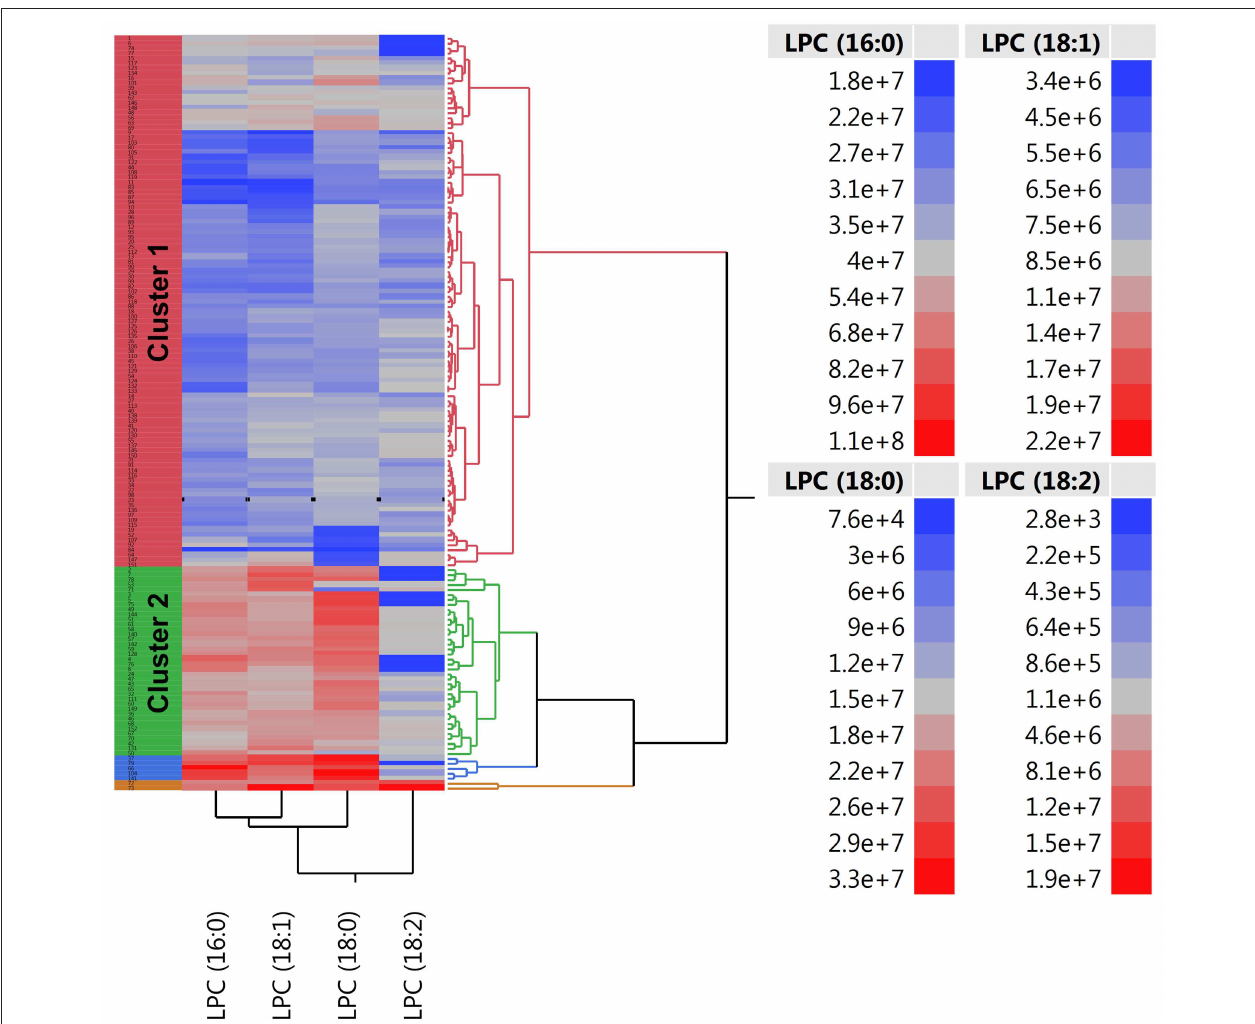
FIGURE 3 | Two-way hierarchical clustering heatmap of plasma LPC (16:0), LPC (18:0), LPC (18:1), and LPC (18:2). Red and blue color represents high and low abundance of metabolites, respectively.